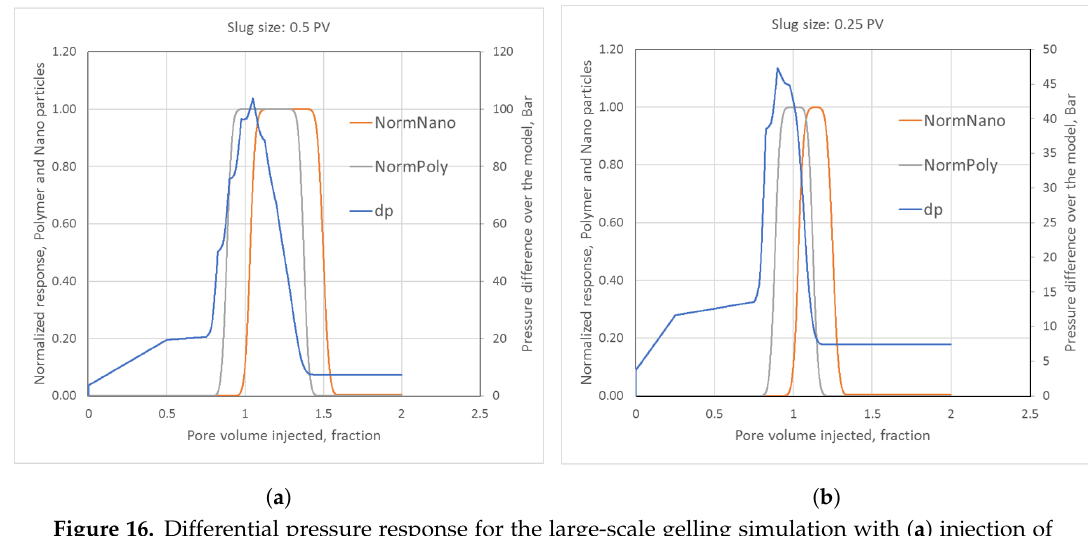
Figure 16. Differential pressure response for the large-scale gelling simulation with ( a ) injection of 0.5 PV polymer and nanomaterial slug and ( b ) injection of 0.25 PV polymer and nanomaterial slug, both followed by SSW